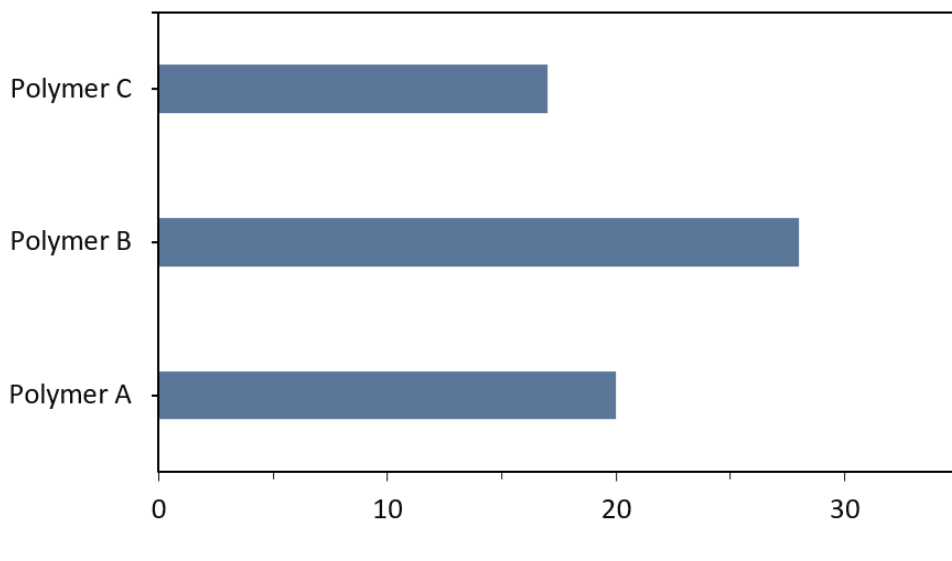
Figure 7. Comparison of average extrusion forces between HA gels in their commercial syringes.